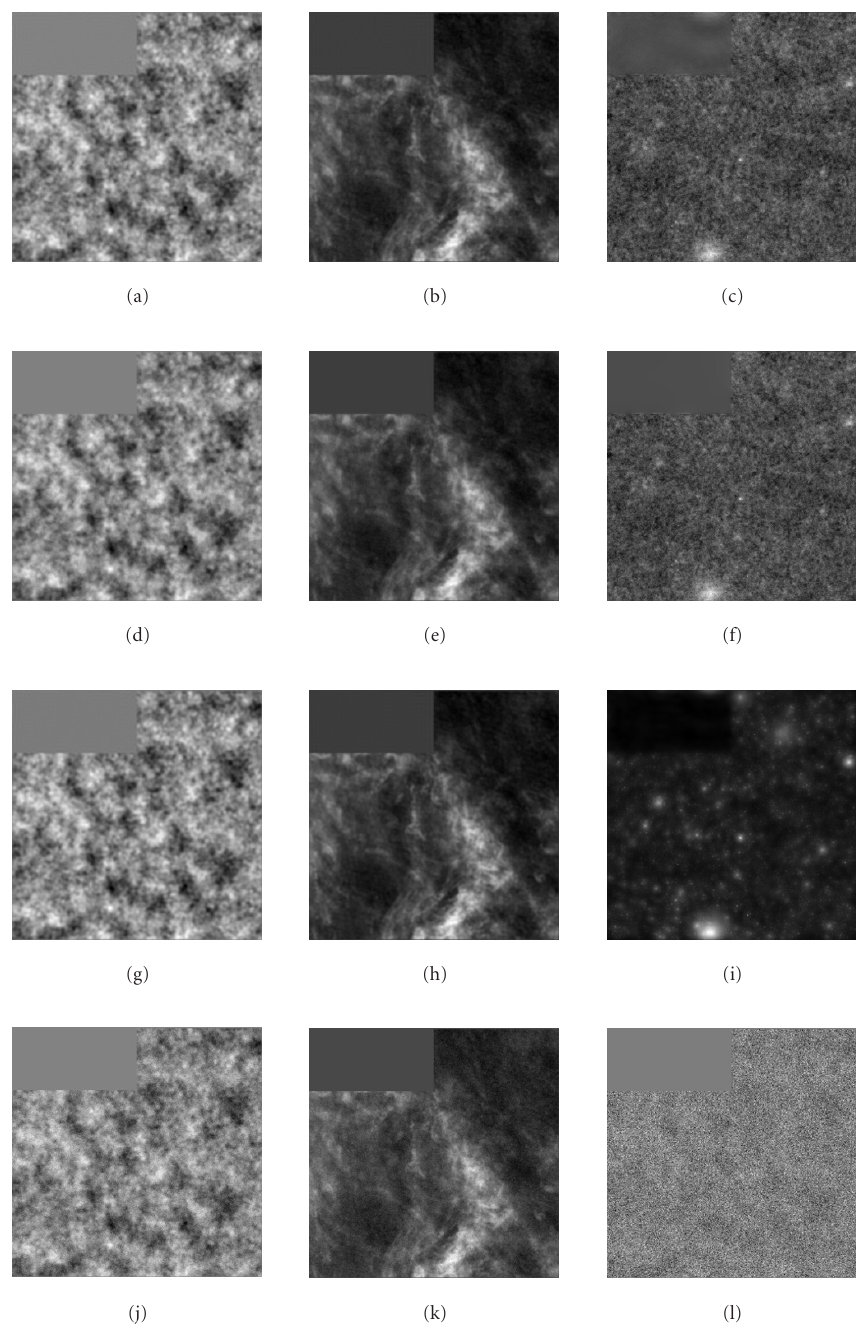
Figure 13: (a)–(f) Estimated component maps obtained with SMICA and wSMICA, respectively. These estimates result from applying a Wiener filter in each frequency band or wavelet scale based on the optimized model parameters (see Section 2.3). (g)–(i) The initial source templates after applying the optimal Wiener filter obtained with SMICA, that is, the same as (a)–(c) but leaving out noise and residual contaminations. (j)–(l) Maps estimated using JADE [27]. The initial source maps are shown in Figure